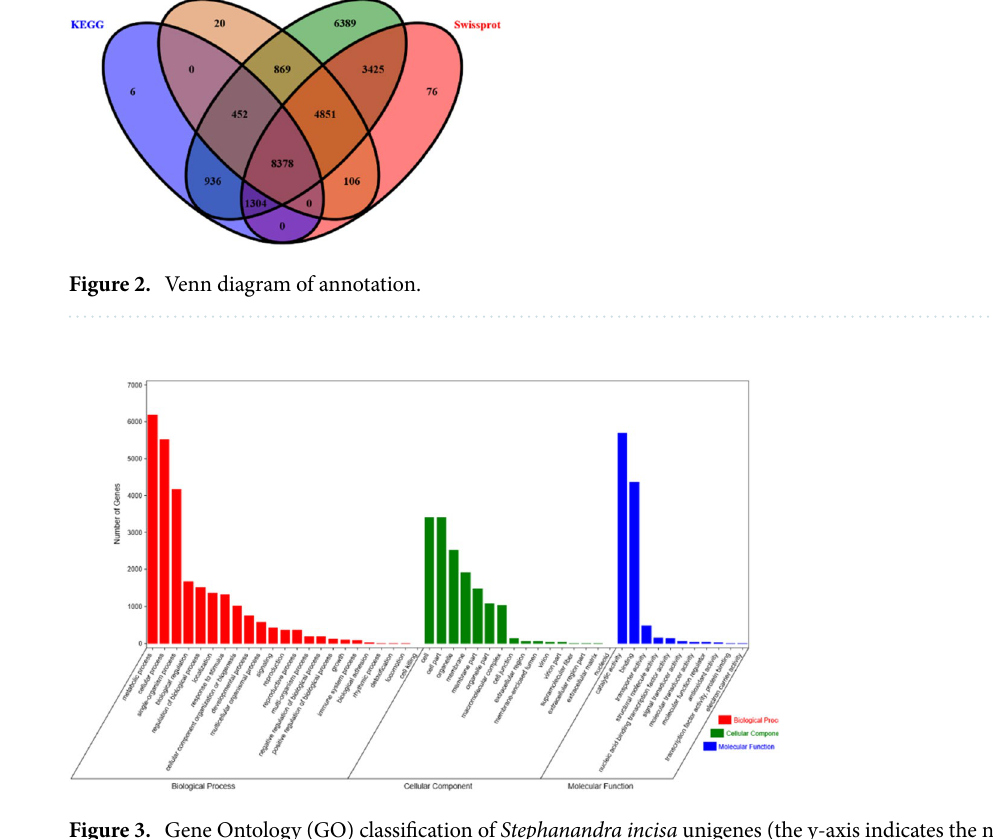
Figure 3. Gene Ontology (GO) classification of Stephanandra incisa unigenes (the y-axis indicates the number of unigenes in the GO databases. The y-axis indicates Gene Ontology (GO) classification of Stephanandra incisa